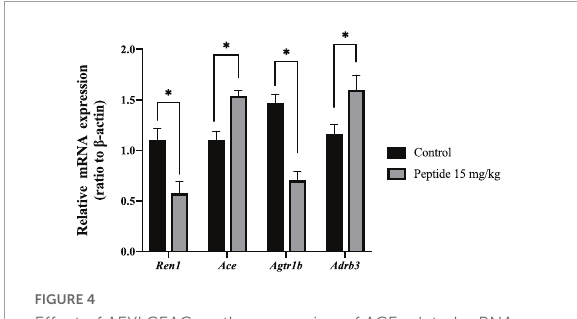
FIGURE4 Effect of AEYLCEAC on the expression of ACE related mRNA. ∗ p < 0.05.